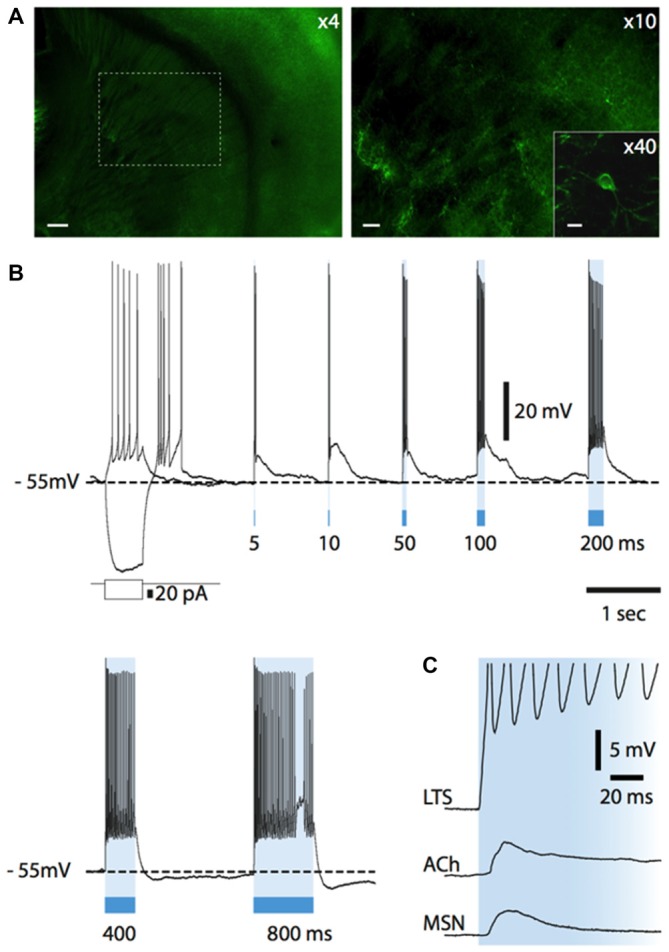
Light-evoked responses of striatal neurons in Som-ChR2 mice. (A) Fluorescent photomicrography of a Som-ChR2 mouse brain slice, comprising striatum, corpus callosum and cortex (left). In the right panel, the part of striatum contained in the dashed square in the left panel is shown at higher magnification. Several eYFP-positive somata and their extensive arborizations can be identified. The inset shows an eYFP-positive cell and its primary dendrites. Calibration bars: 200 μm (left panel), 60 μm (right panel) and 20 μm (inset). (B) Responses of an eYFP-positive neuron to a negative and a positive current step (superimposed) and to several light pulses of increasing length. A rebound low-threshold calcium spike, accompanied by several action potentials, was present after termination of the negative current pulse. Light pulses of increasing duration (5–800 ms) were applied after the negative current step. Even the shortest light pulse (5 ms) elicited a strong supra-threshold response in the interneuron. LTSs developing after termination of the light stimulus are evoked by 5, 10, 50 and 100 ms pulses. Longer light pulse lengths evoke prolonged action potential firing. (C) In an eYFP-positive LTS interneuron, a light pulse evoked a short-latency (<1 ms), persistent supra-threshold depolarization. Other neuronal types (cholinergic interneurons, MSNs) tested with the same protocol displayed much smaller and transient initial responses with a substantially longer latency (>5 ms). Resting potentials were −78 mV (MSN), −64 mV (cholinergic interneuron), −64 mV (LTS interneuron).